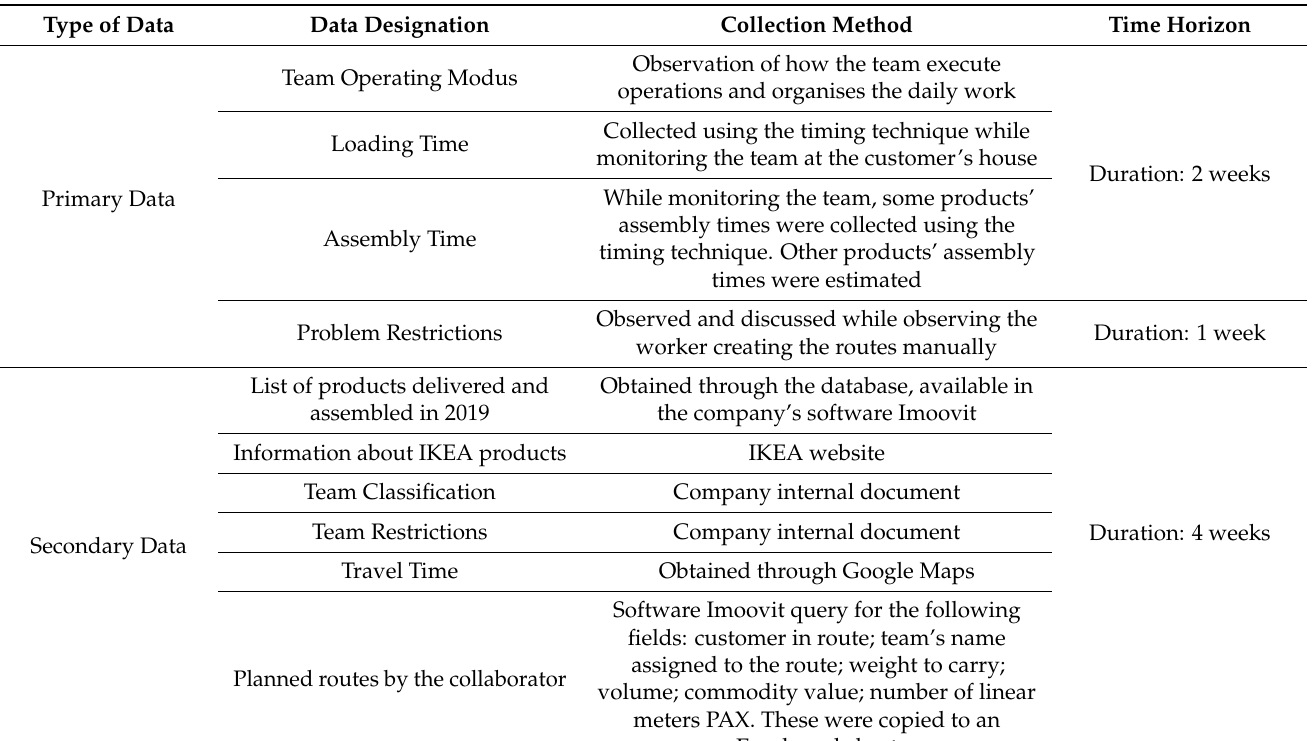
Table 4. Primary and secondary data